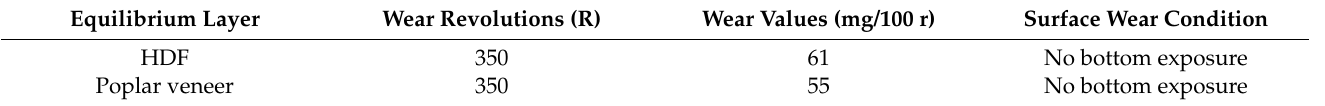
Table 2. Surface wear resistance of ecological board prepared with different equilibrium layers.